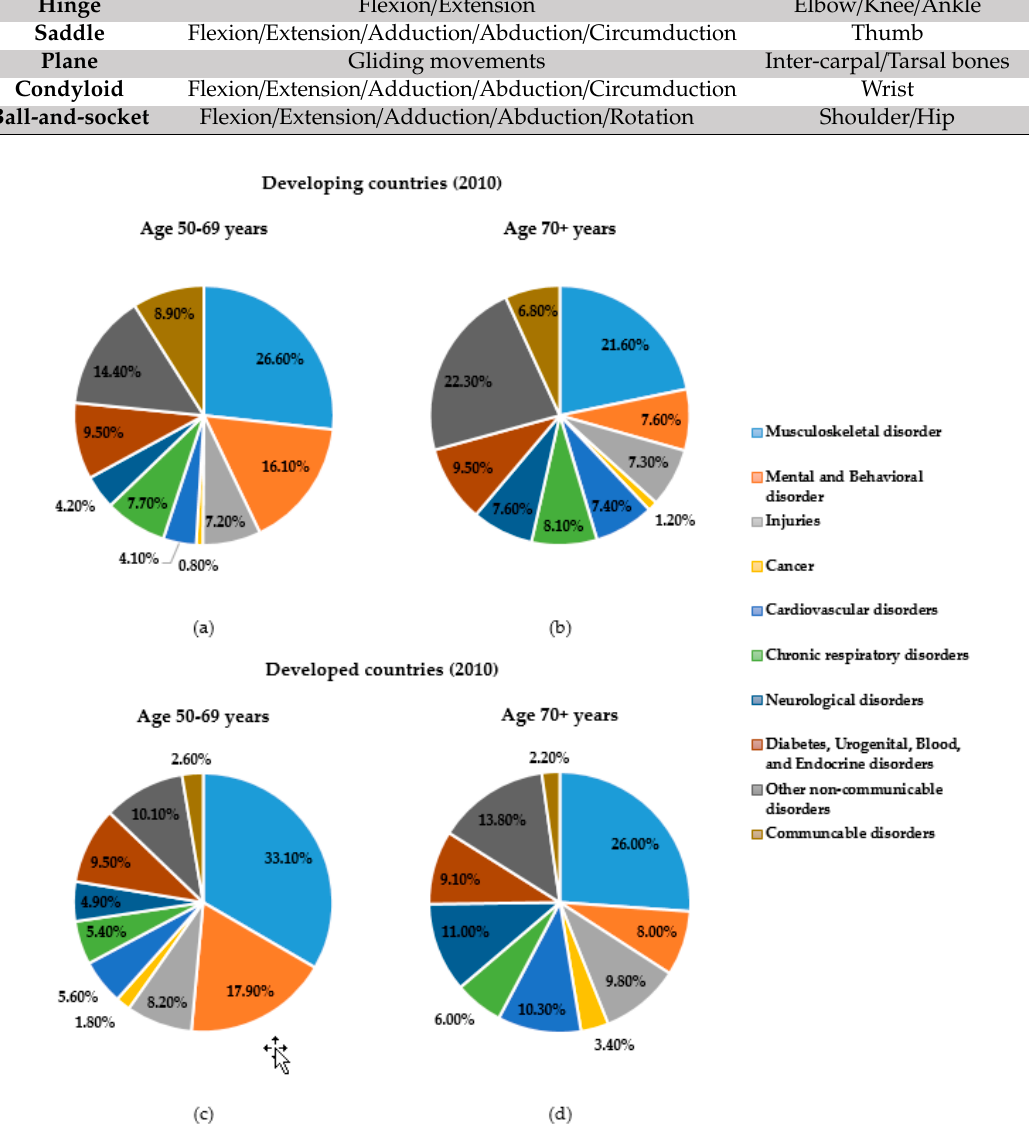
Figure 2. Proportion of total global years lived with disability (YLDs) in older age (50 years and more) groups attributable to each major set of health conditions in developing countries ( a ) 50–69 years; ( b ) 70 + years; and developed countries ( c ) 50–69 years; ( d ) 70 + years. Source: The Global Burden of Disease Study 2010 (GBD 2010).